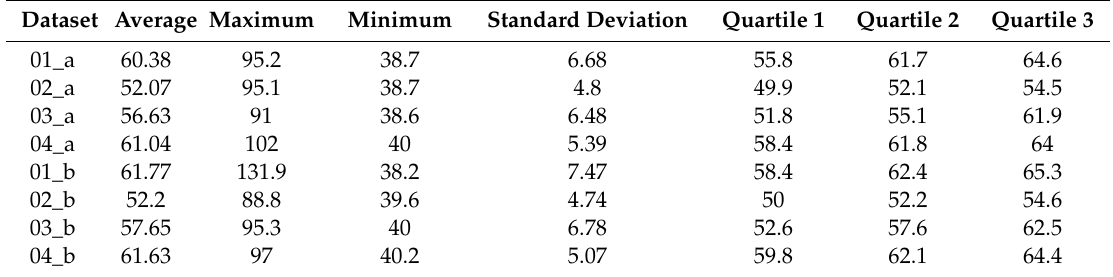
Table 4. Descriptive statistics for noise time series of di ff erent data sets /